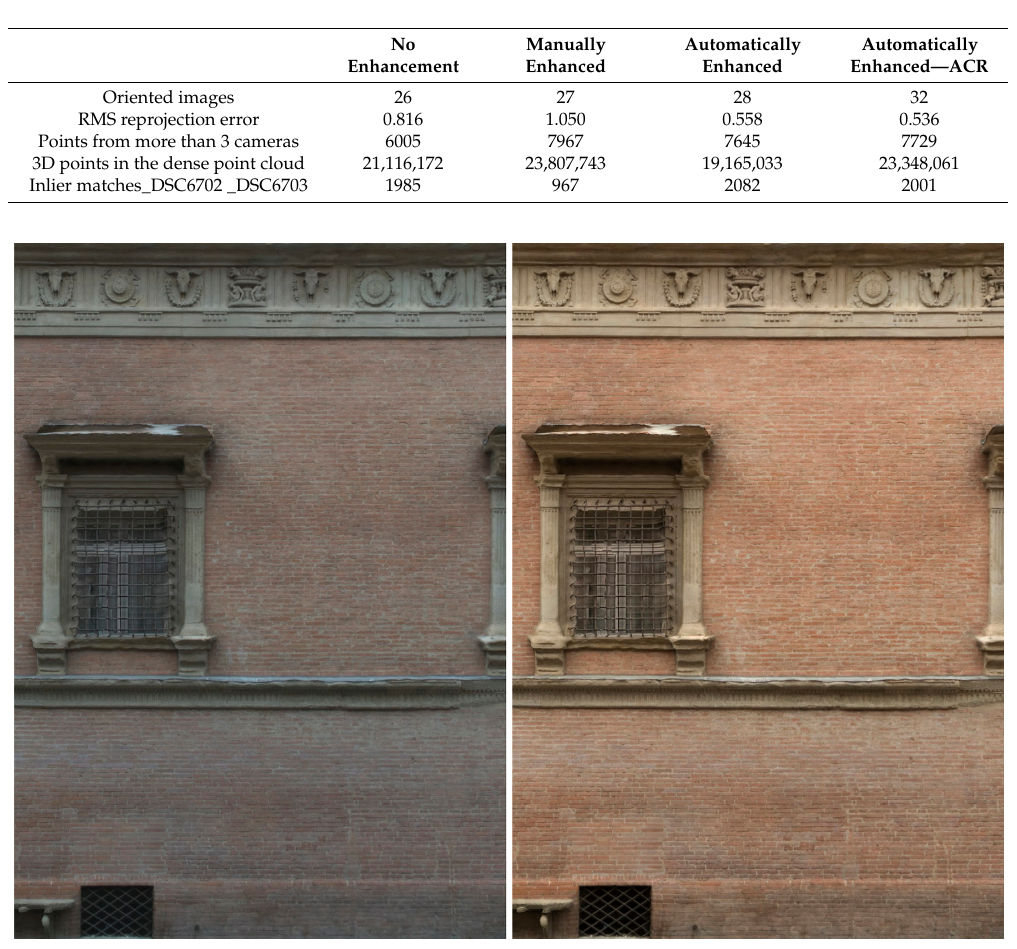
Table 4. “Building with portico” dataset—photogrammetric process results.